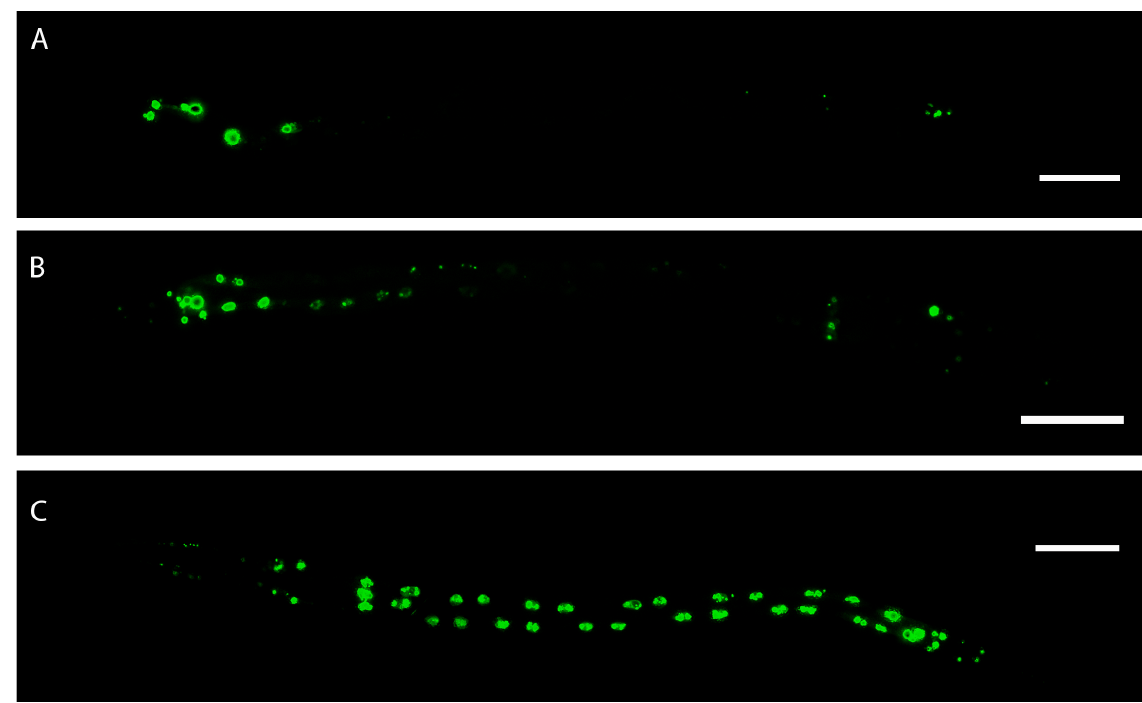
Fig 4. Representative images of C . elegans expressing numr-1 ::GFP depending on treatment with the hydroethanolic extract from C . mucronatum . A: negativecontrol (DMSO 1%); B: treatment with 0.2 mg/mL extract; C: treatment with 2 mg/mL extract. Scale bars = 100 μ